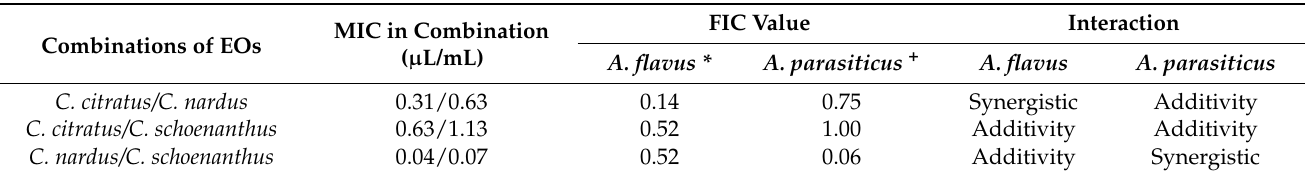
Table 6. Effect of essential oil combinations on Aspergillus flavus and Aspergillus parasiticus . MIC in Combinations of EOs